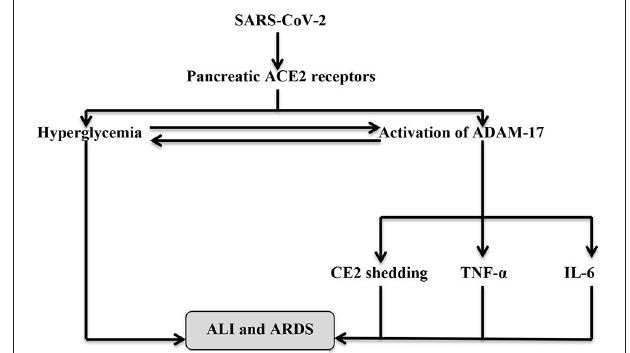
FIGURE 3 | The interaction between SARS-CoV-2 and pancreatic ACE2. Binding of SARS-CoV-2 to the pancreatic ACE2 leads to pancreatic injury (PI)-induced hyperglycemia and activation of A disintegrin and metalloprotease-17 (ADAM-17), which activate shedding of ACE2 receptors and production of TNF- α and IL-6. Hyperglycemia activates ADAM-17 and vice versa. These changes together participate in the development of ALI and